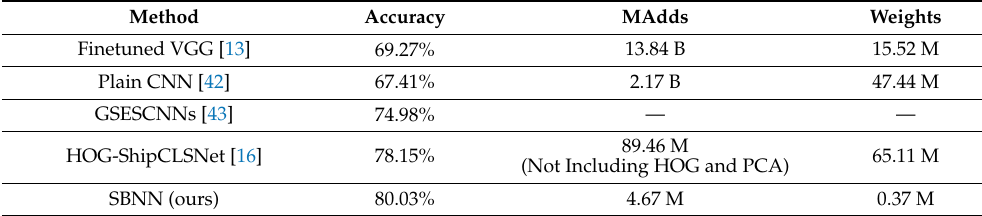
Table 5. The results in the three-categories SAR ship classification task.